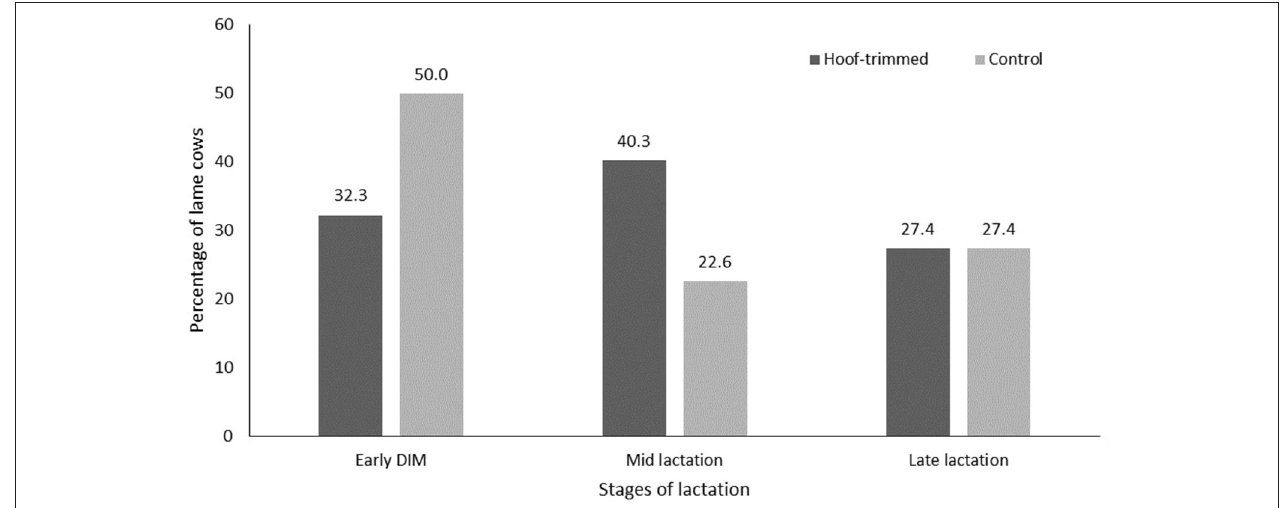
FIGURE 2 | Percentage of lame cows among the hoof-trimmed and control cows at various stages of lactation during the study.